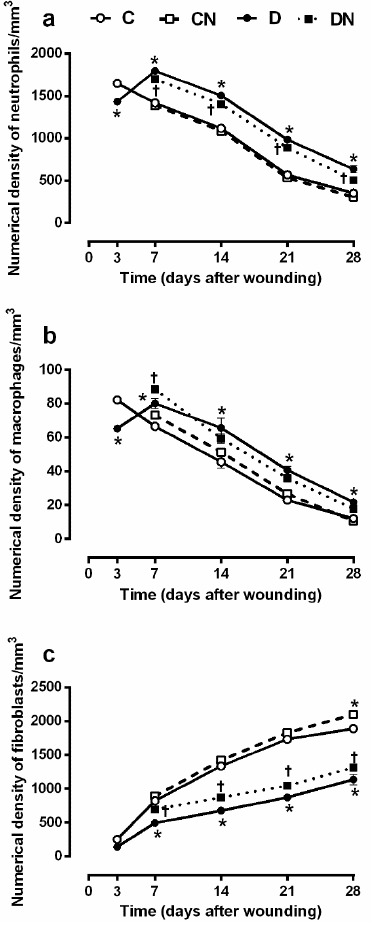
Figure 4. Effect of topical acidified nitrite application on the numerical density of neutrophils ( a ), macrophages ( b ), and fibroblasts ( c ). C, untreated control; CN, acidified nitrite-treated control; D, untreated diabetes; and DN, acidified nitrite-treated diabetes. * p < 0.05 compared to untreated control rats, and † p < 0.05 compared to untreated diabetic rats. Values are mean ± SEM, n =